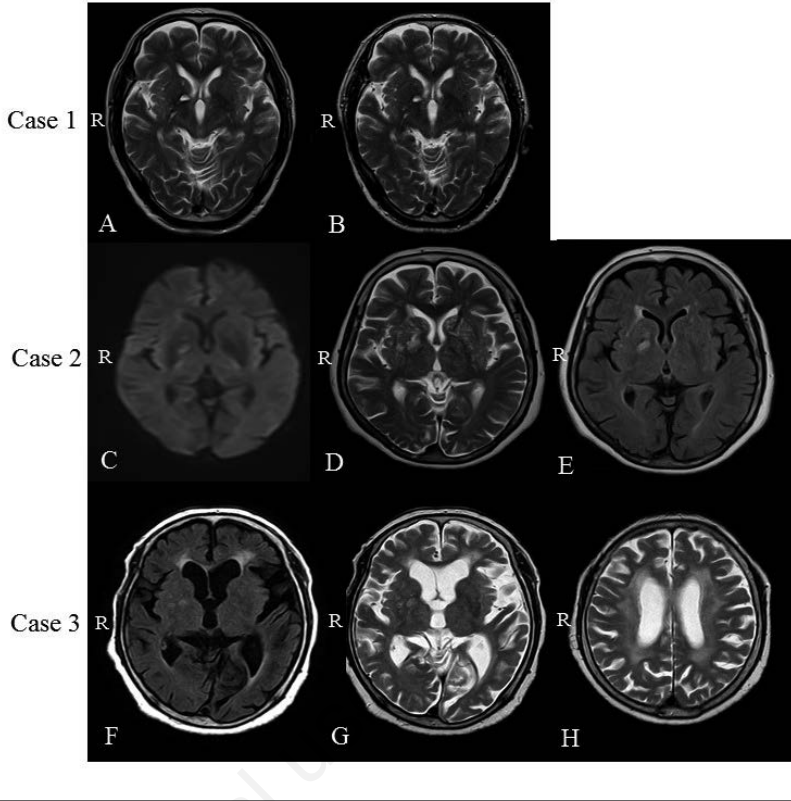
Figure 1. Magnetic resonance image findings for the three hemichorea-hemiballism cases. In case 1, brain magnetic resonance image (MRI) shows the old cerebral infarct in the right globus pallidus present for the past four years (A: T2 weighted MRI image (T2WI)at the onset, B: T2WI at the four years before the onset). In case 2, MRI shows the subacute cerebral infarcts in the right globus pallidus (C; Diffusion weighted image(DWI), D; T2WI, and E; Fluid attenuated inversion recovery(FLAIR)). In case 3, MRI shows periventricular hyperdensity (PVH), old infarcts in right globus pallidus and putamen (F; FLAIR, G; T2WI, and H; T2WI).